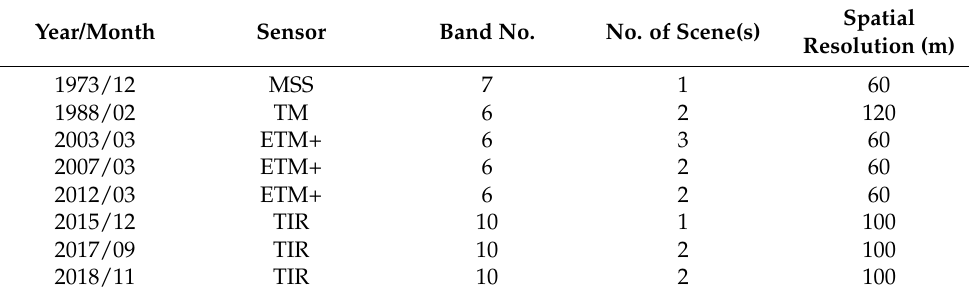
Table 1. Summary of the Landsat imagery used for CFLs